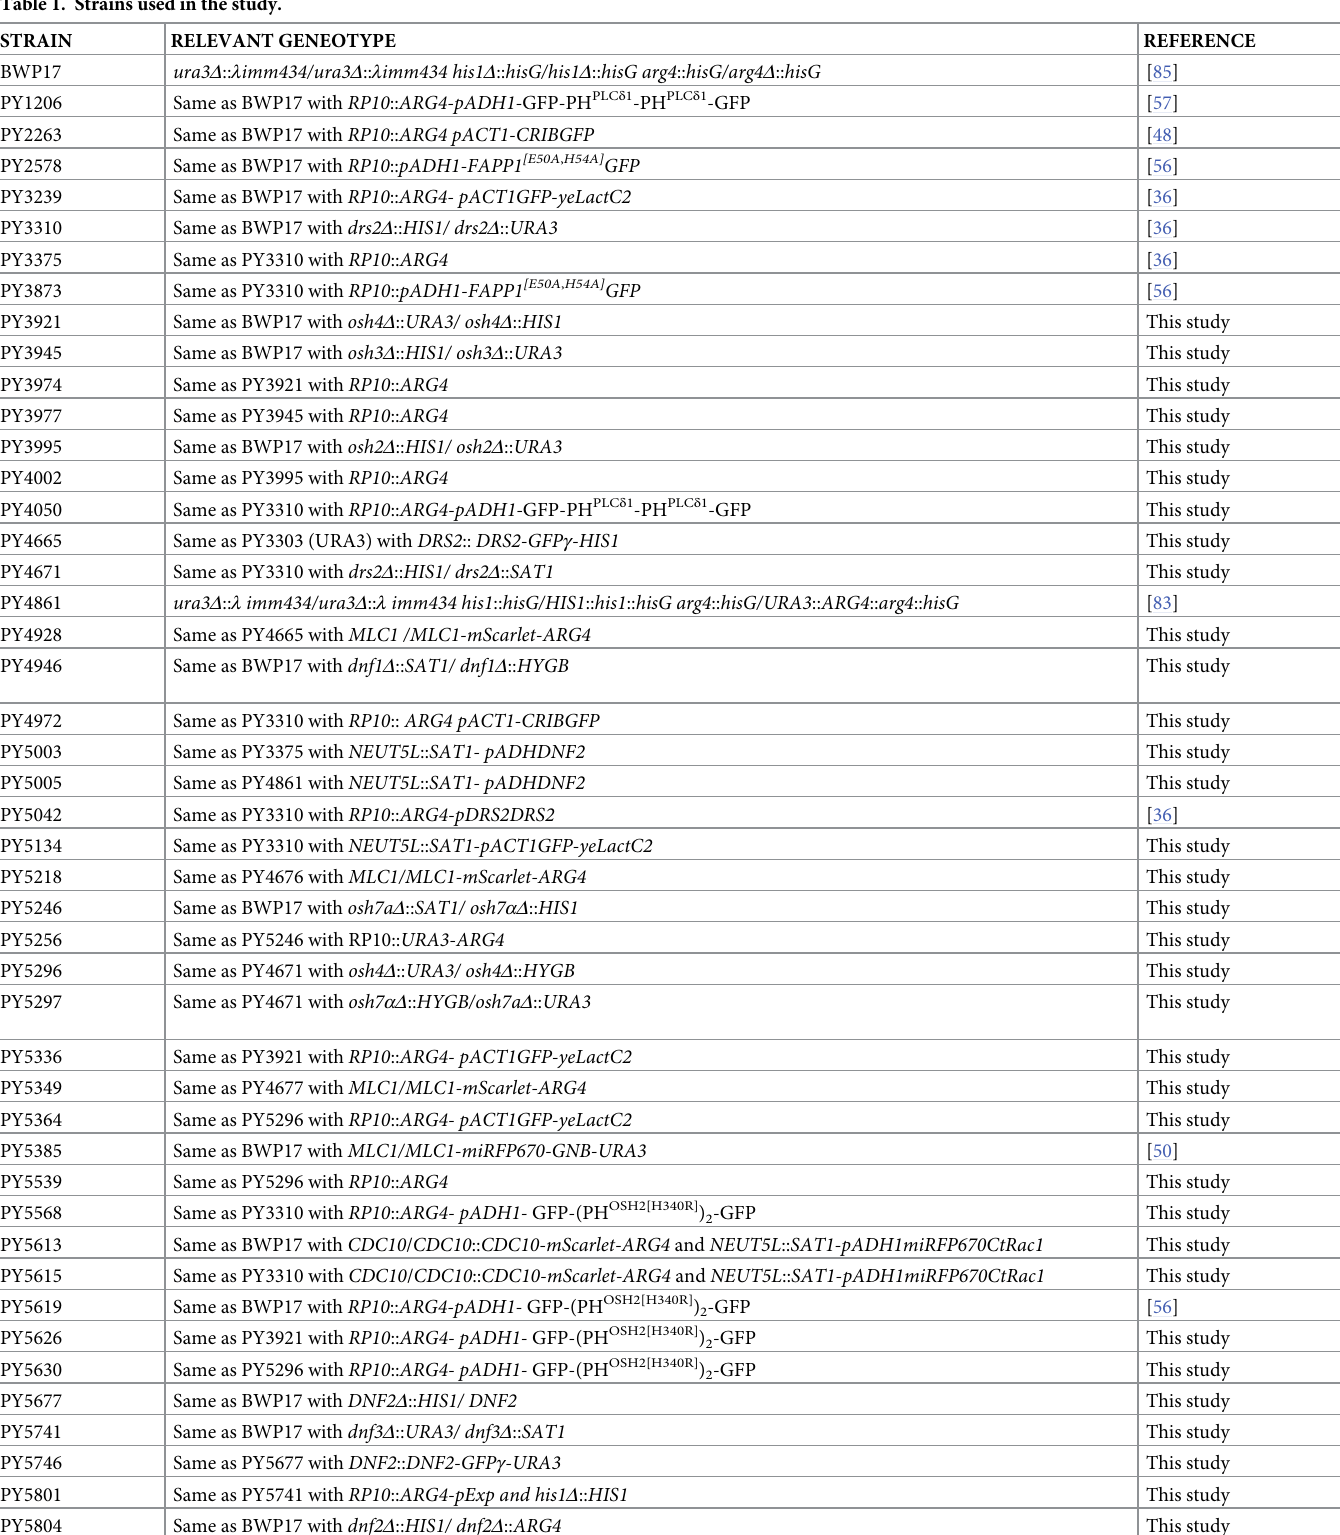
Table 1. Strains used in the study. STRAIN RELEVANT GENEOTYPE